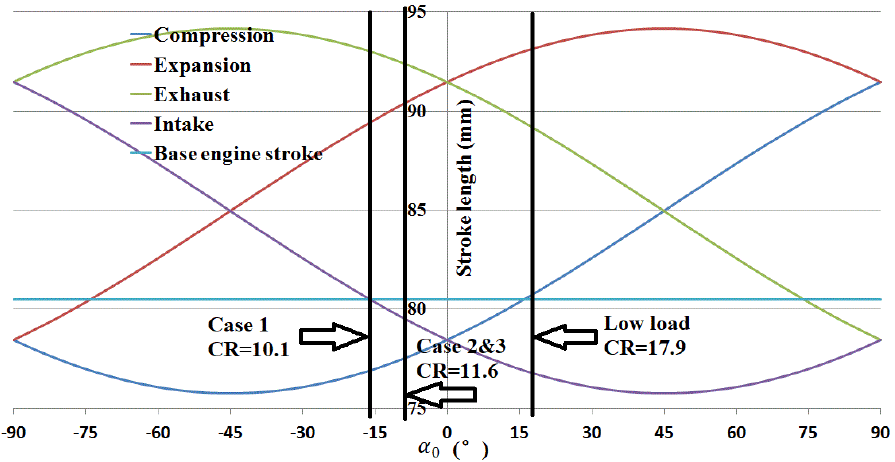
Figure 12. Variation of stroke length with α 0 .